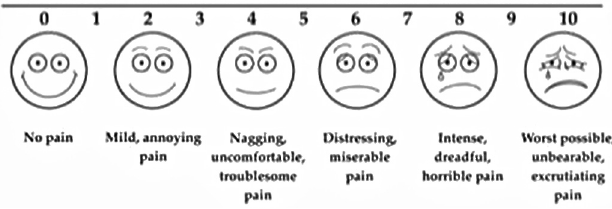
Fig. 1. Scoring of VAS (0 – 10 with 0 being no pain, 5 being moderate pain, and 10 being the worst possible